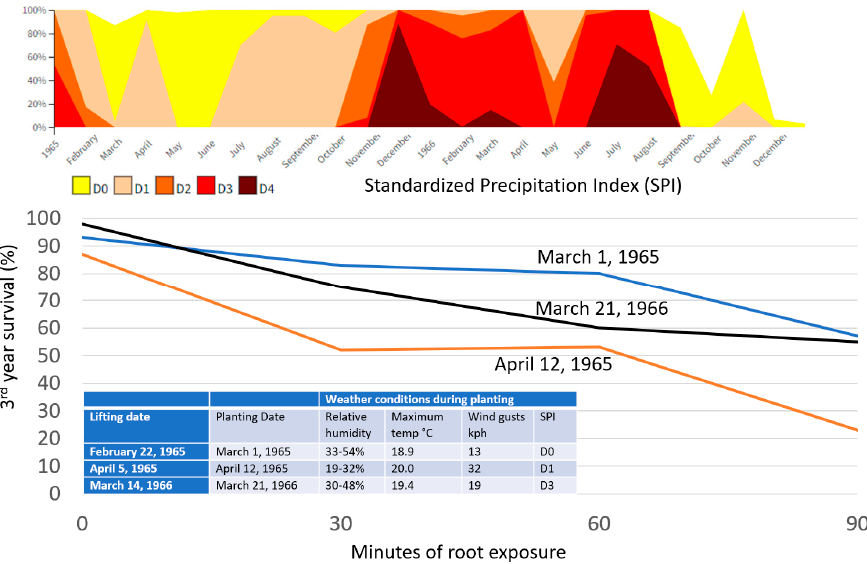
Figure 8. Exposing roots to 30 min of sun in Virginia [62] and then planting in moist soil (Standardized Precipitation Index; SPI = D0; February rain in Appomattox County = 94 mm) reduced survival by 10%. In contrast, when planted in drier soil (SPI = D1; April 1965 rain = 53 mm), the same exposure (SPI = D3; March 1966 rain = 52 mm) reduced survival by 23%. Data from [62]. The least